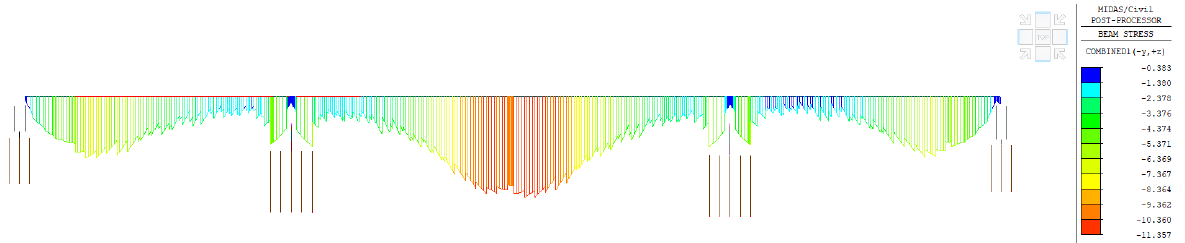
Figure 10. Sample of stress distribution in the top of deck (MPa) at time T=100y - quasi-permanent combination.